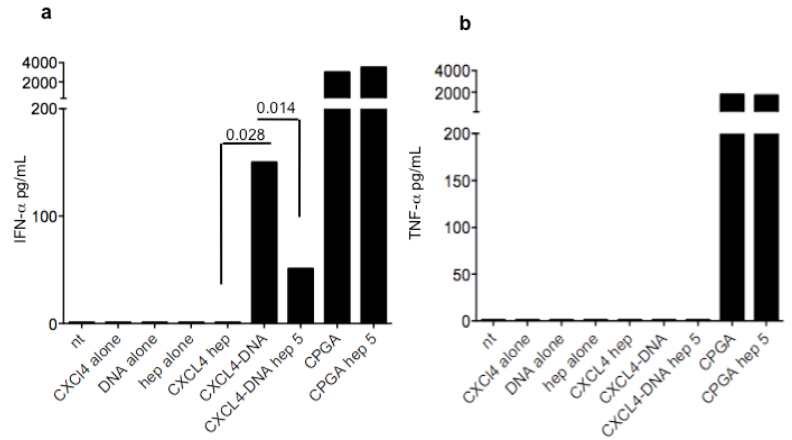
Figure 4. CXCL4-heparin complexes do not stimulate pDC and heparin blocks stimulation by CXCL4-DNA complexes. PDC were cultured with the indicated stimuli and both IFN- α ( a ) and TNF- α ( b ) were assessed on culture supernatants 24 h later by ELISA (see methods). Values of IFN- α and TNF- α concentrations are indicated. Heparin was used at 5 U/mL. Histograms are representative of four independent experiments performed with pDC from different healthy donors. Significance (calculate by Mann-Whitney test) is reported on the graph.